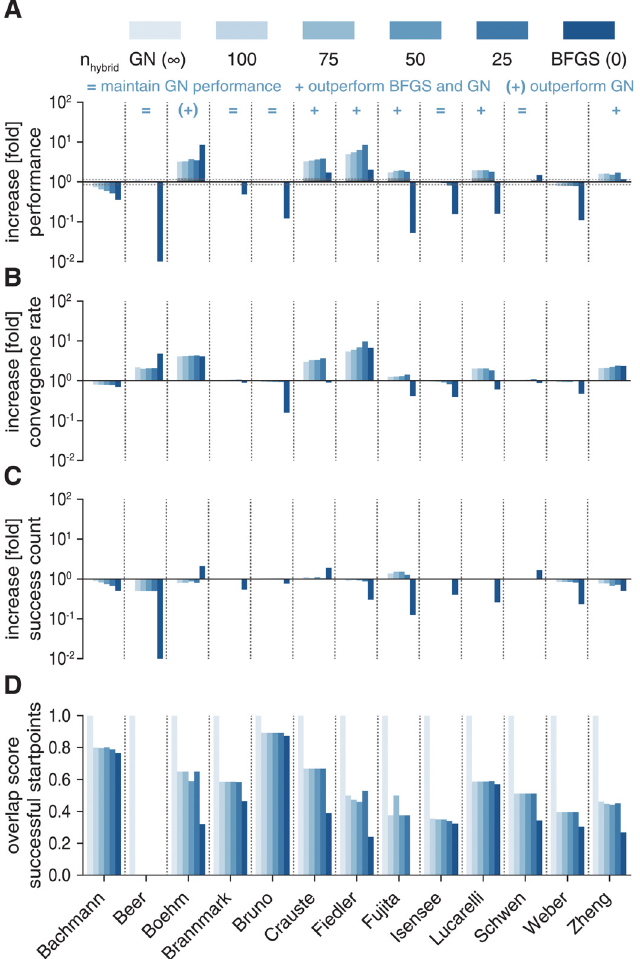
Fig 5. Evaluation of hybrid switching approximation. Color scheme is the same in all panels. All increases/decreases are relative to fides 2D/GN . A : Performance comparison ( ϕ ). B : Increase in convergence count γ . C : Increase in convergence rate ν . D : Overlap score for start-points that yield successful optimization runs with respect to fides 2D/GN .